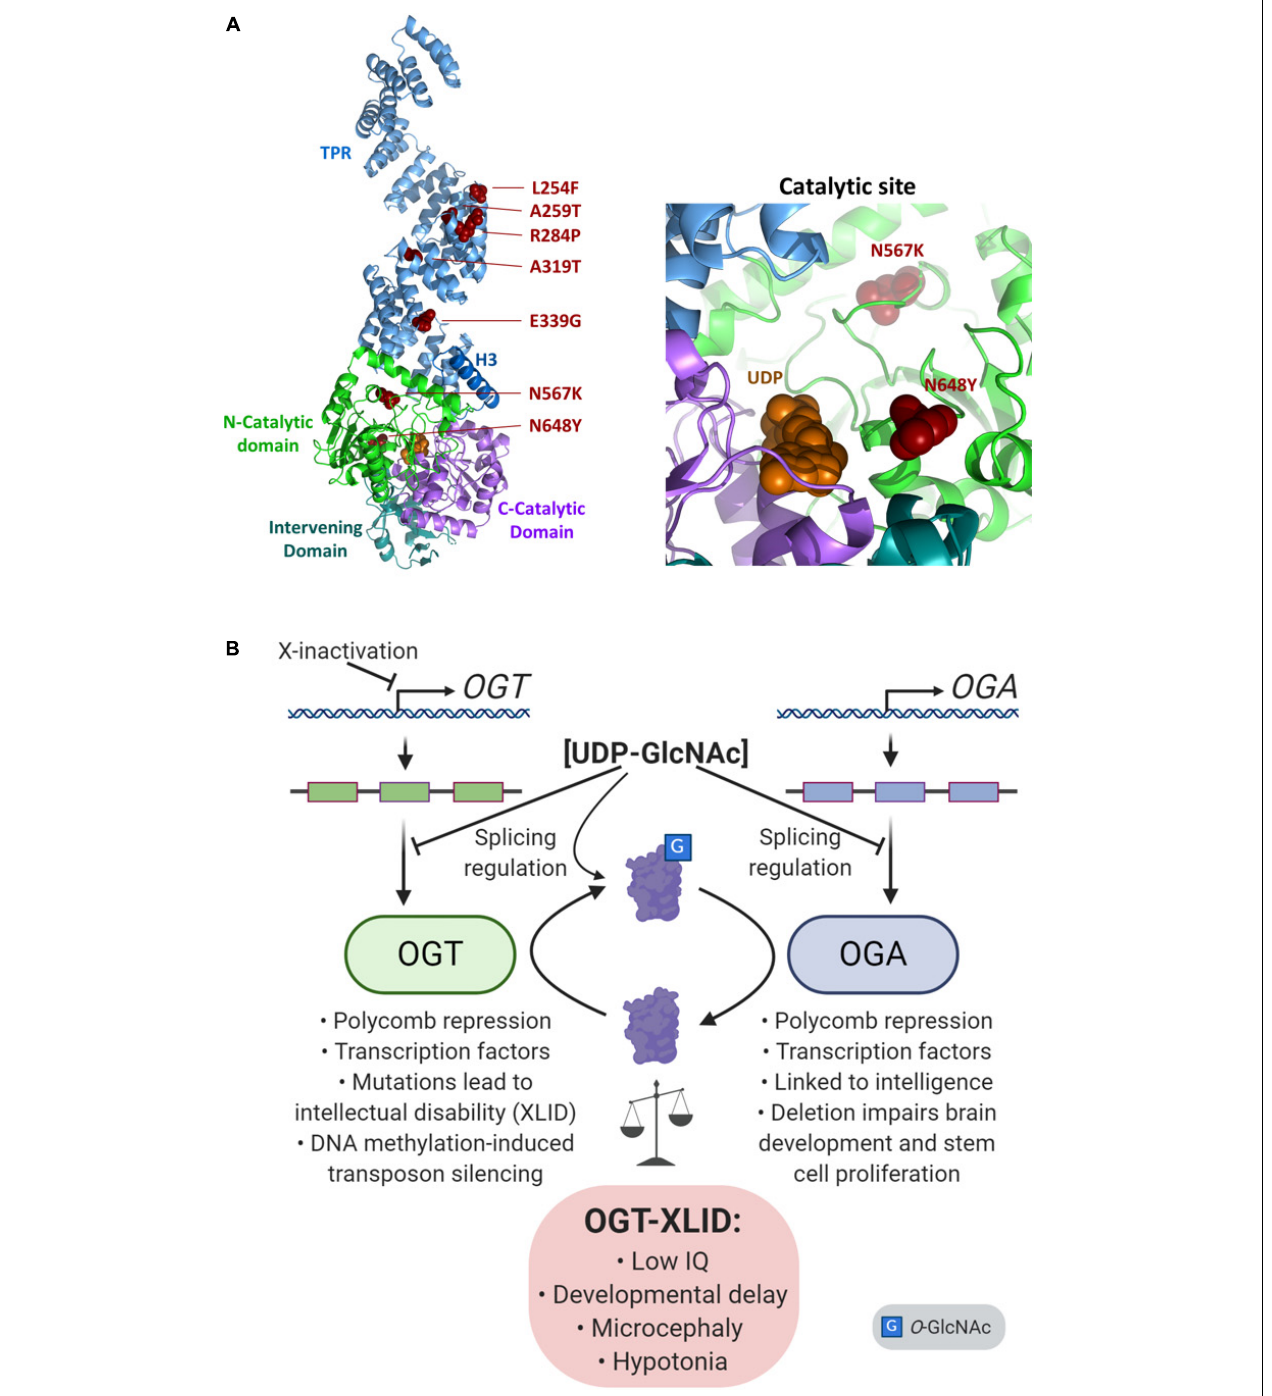
FIGURE 4 | Imbalance of O- GlcNAc cycling leads to epigenetic changes and disease. (A) The presumed structure of OGT (Lazarus et al., 2011) shown as a cartoon in complex with UDP (orange spheres), with sites of OGT-XLID causative variants highlighted (red spheres). Each domain is colored-coded and labeled with its name. To better show the variants in the catalytic domain, a zoomed panel rotated 180 ◦ about the y -axis from the full structure is shown on the right. (B) Expression of both OGT and OGA are regulated by cellular concentrations of UDP-GlcNAc through splicing mechanisms. As an X-chromosome gene, OGT is also regulated by X-inactivation. OGT and OGA proteins dynamically cycle O- GlcNAc to regulate many epigenetic mechanisms such as the Polycomb repressive complexes and regulation of transcription factors. In addition, both genes are linked to intelligence: OGT mutations cause intellectual disability, and a GWAS meta-analysis found OGA is associated with intelligence (Savage et al., 2018). Deletion of Oga disrupts proper neural development and the proliferation of mouse embryonic stem cells (Olivier-Van Stichelen et al., 2017).